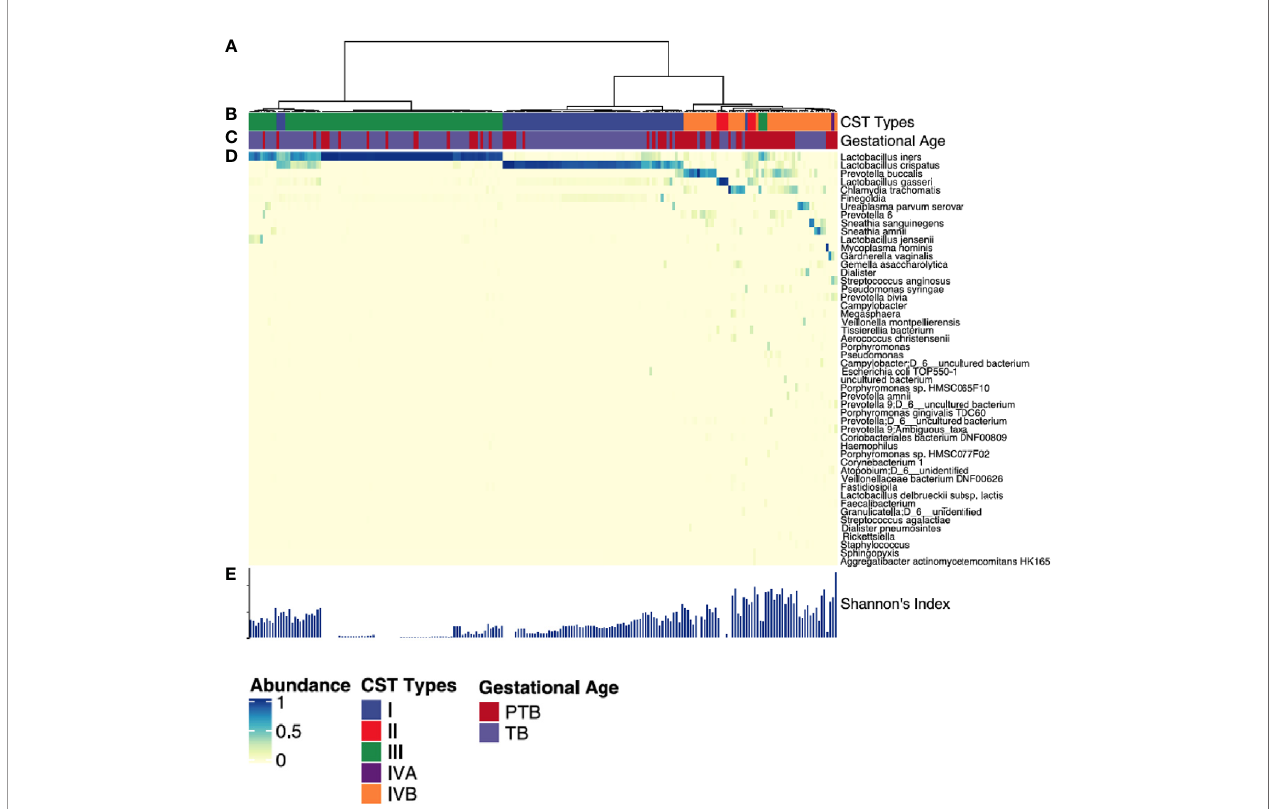
FIGURE 4 | Vaginal microbiota pro fi les of women who had PTB and TB deliveries. (A) Hierarchical clustering of Euclidean distance matrices with Ward linkage on relative abundances of reads for each OTU within individual vaginal swab samples collected at all time points. (B) Community state types (CST) identi fi ed across all the study subjects. Each CST is represented by a different color according to the key shown underneath. (C) Gestational age category (PTB shown in red, TB shown in blue). (D) Heatmap of relative abundances of bacterial species within the vaginal microbiota of each woman. Each column represents a woman ’ s vaginal microbiota pro fi le, and each row represents a bacterial species. Only species that represent at least 0.5% of the total microbiome in at least one sample are shown. (E) Shannon diversity indices calculated for each sample. Each CST is represented by a different color: CST-I, Lactobacillus crispatus -dominated; CST-II, Lactobacillus gasseri -dominated; CST-III, Lactobacillus iners -dominated; CST-IVA, lower abundance of Lactobacillus spp together with low proportions of anaerobic bacteria such as Anaerococcus, Corynebacterium, and Streptococcus ; CST-IVB: dominated by higher abundance of the genera Atopobium, Prevotella,